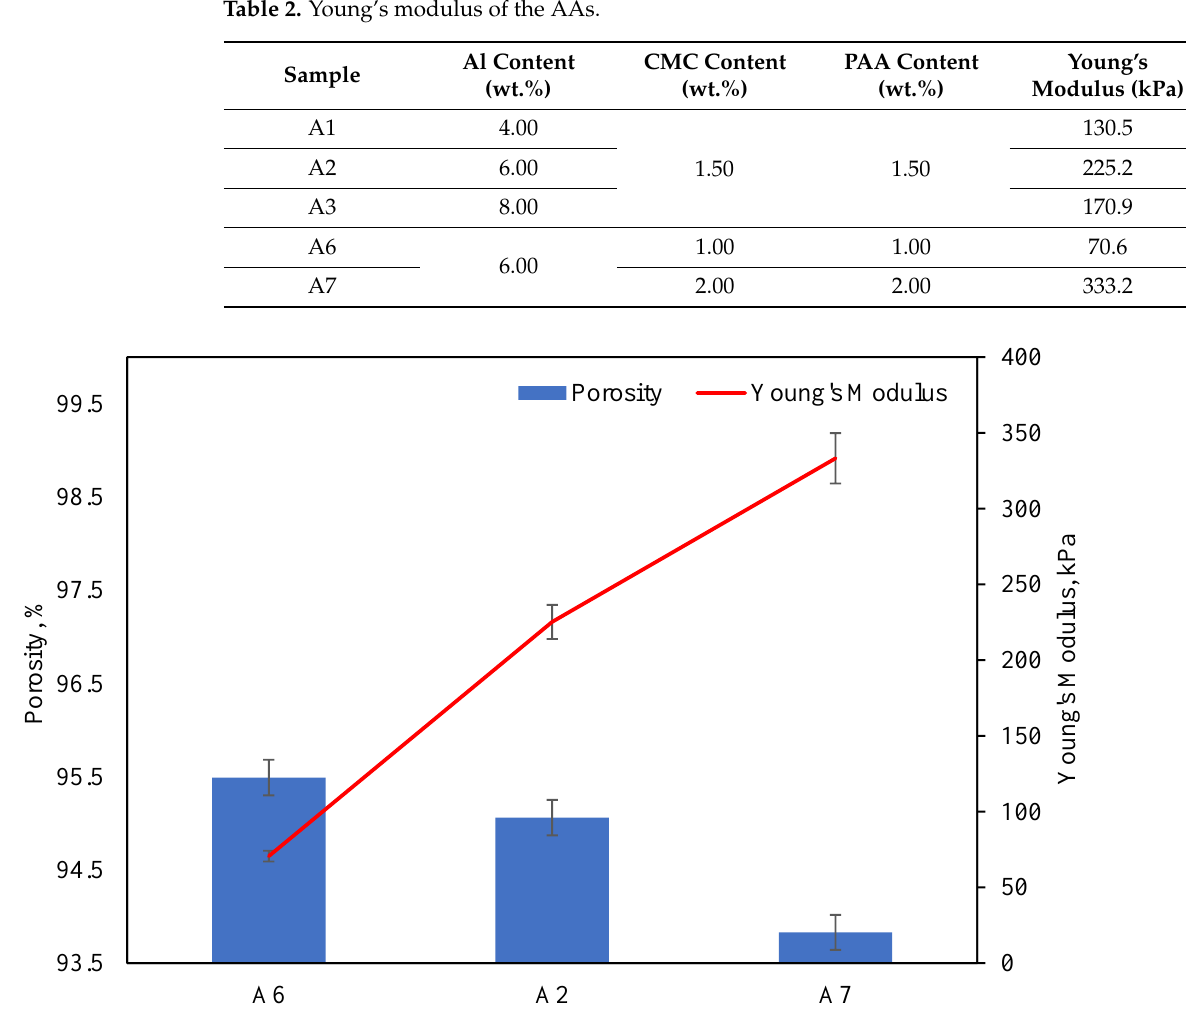
Figure 12. Comparison of Young’s modulus and porosity for samples with increasing crosslinker concentration.